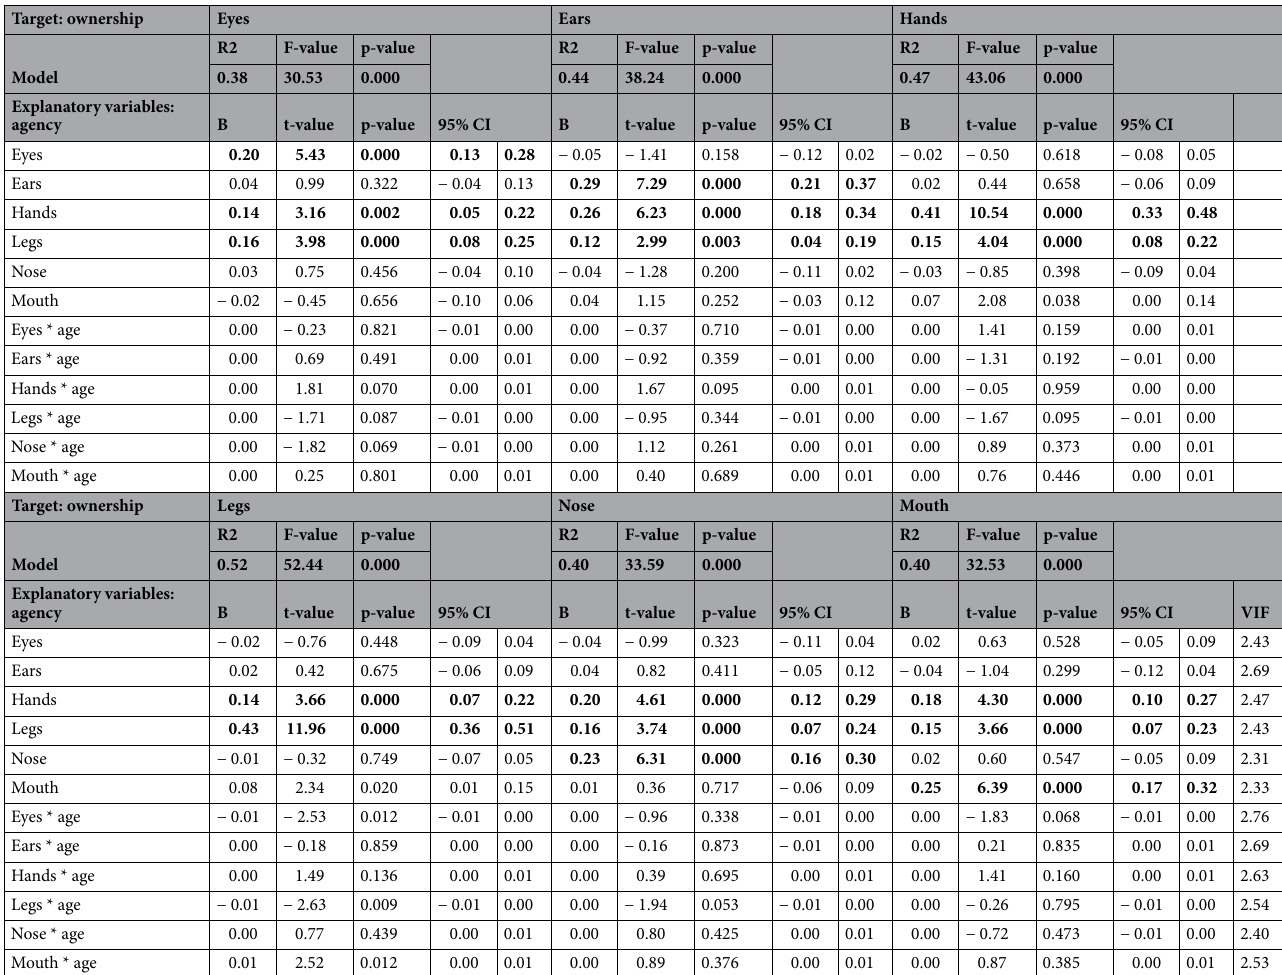
Table 2. Statistics of multiple regression analyses from the agency sensations to ownership sensation in each body part. Bold letters indicate significant beta